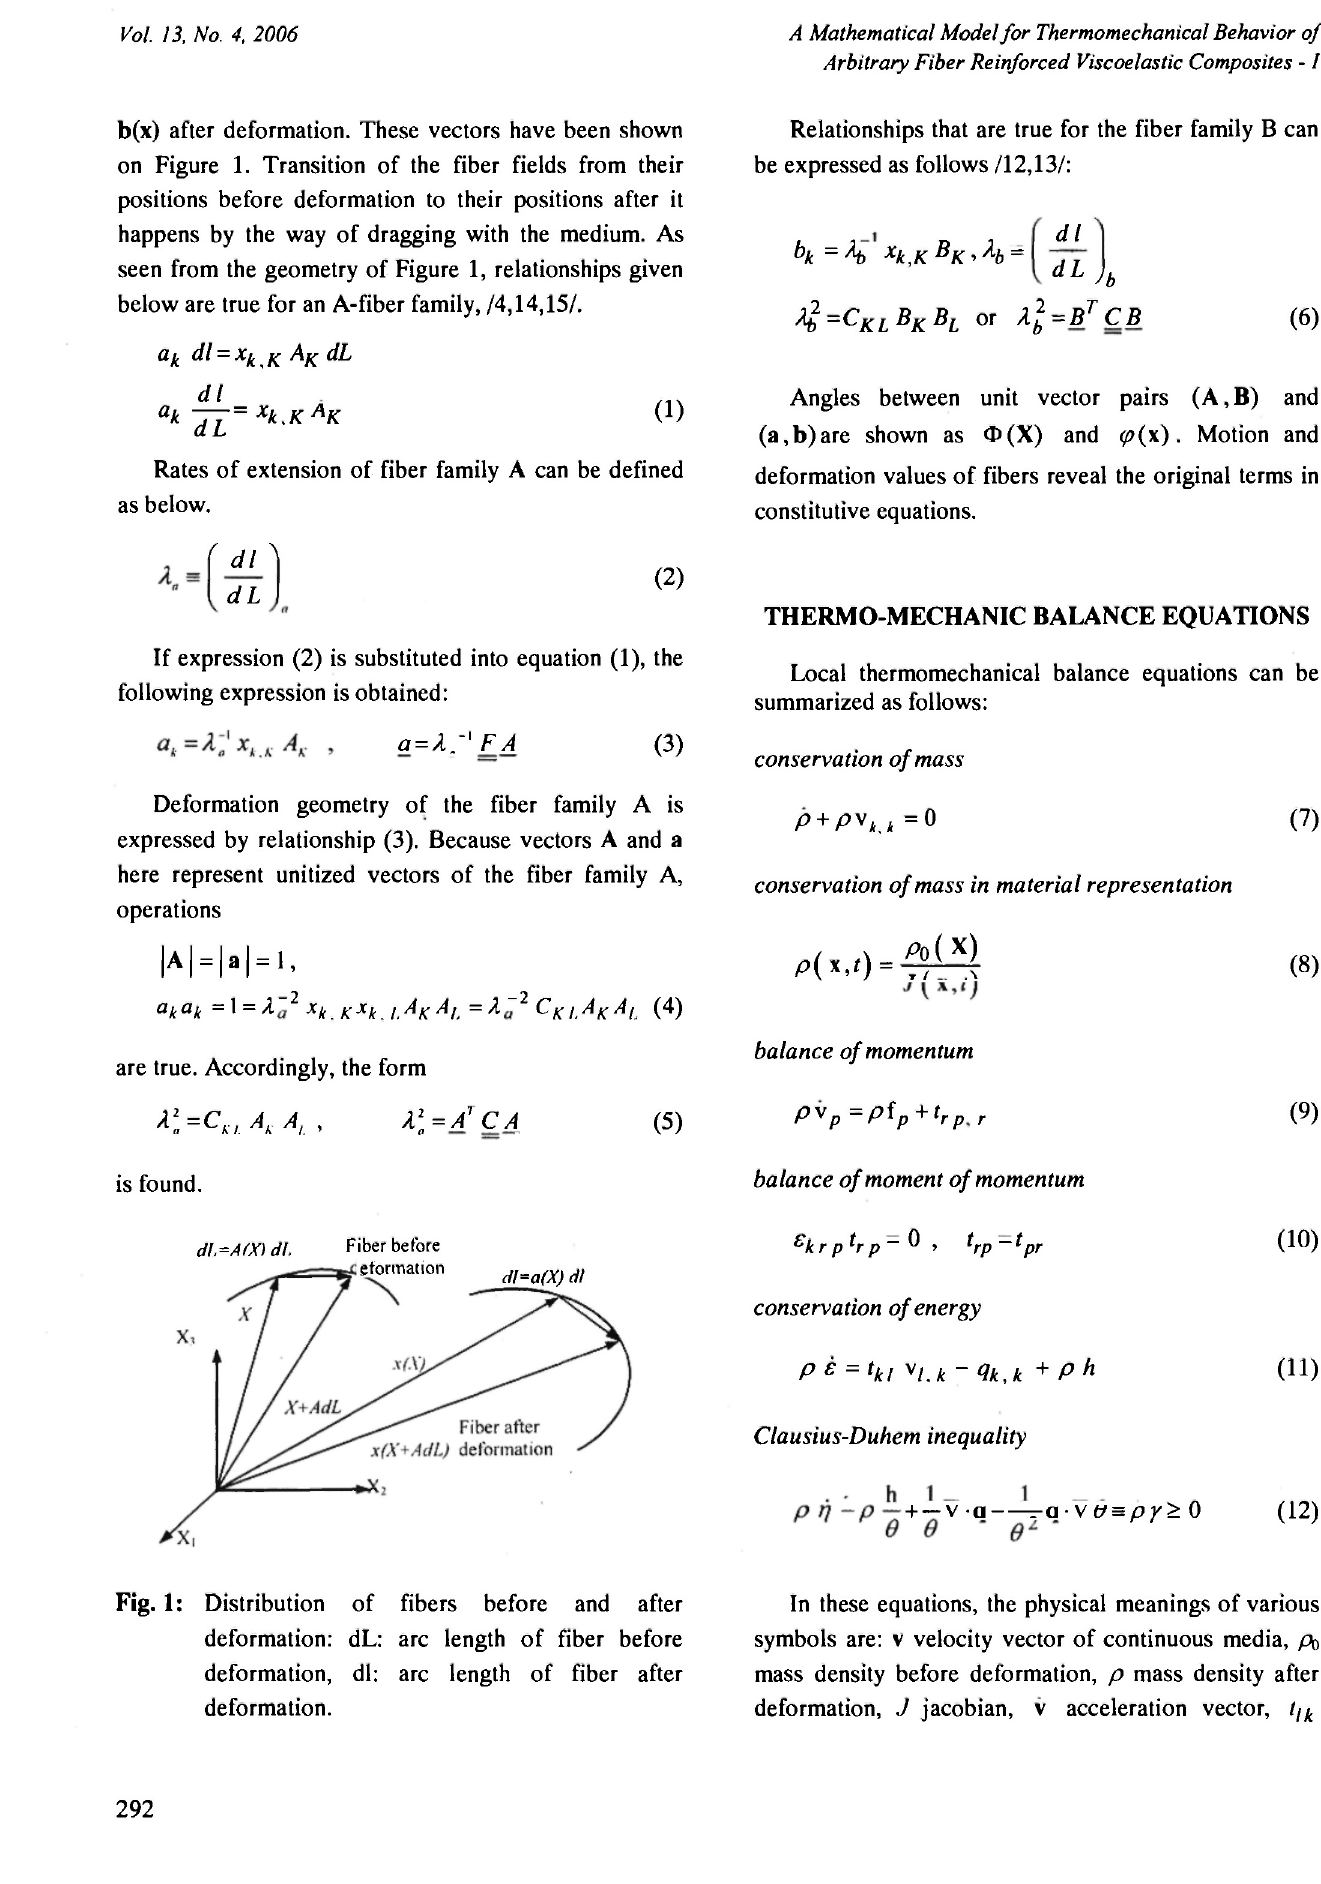
Fig. 1: Distribution of fibers before and after deformation: dL: arc length of fiber before deformation, dl: arc length of fiber after